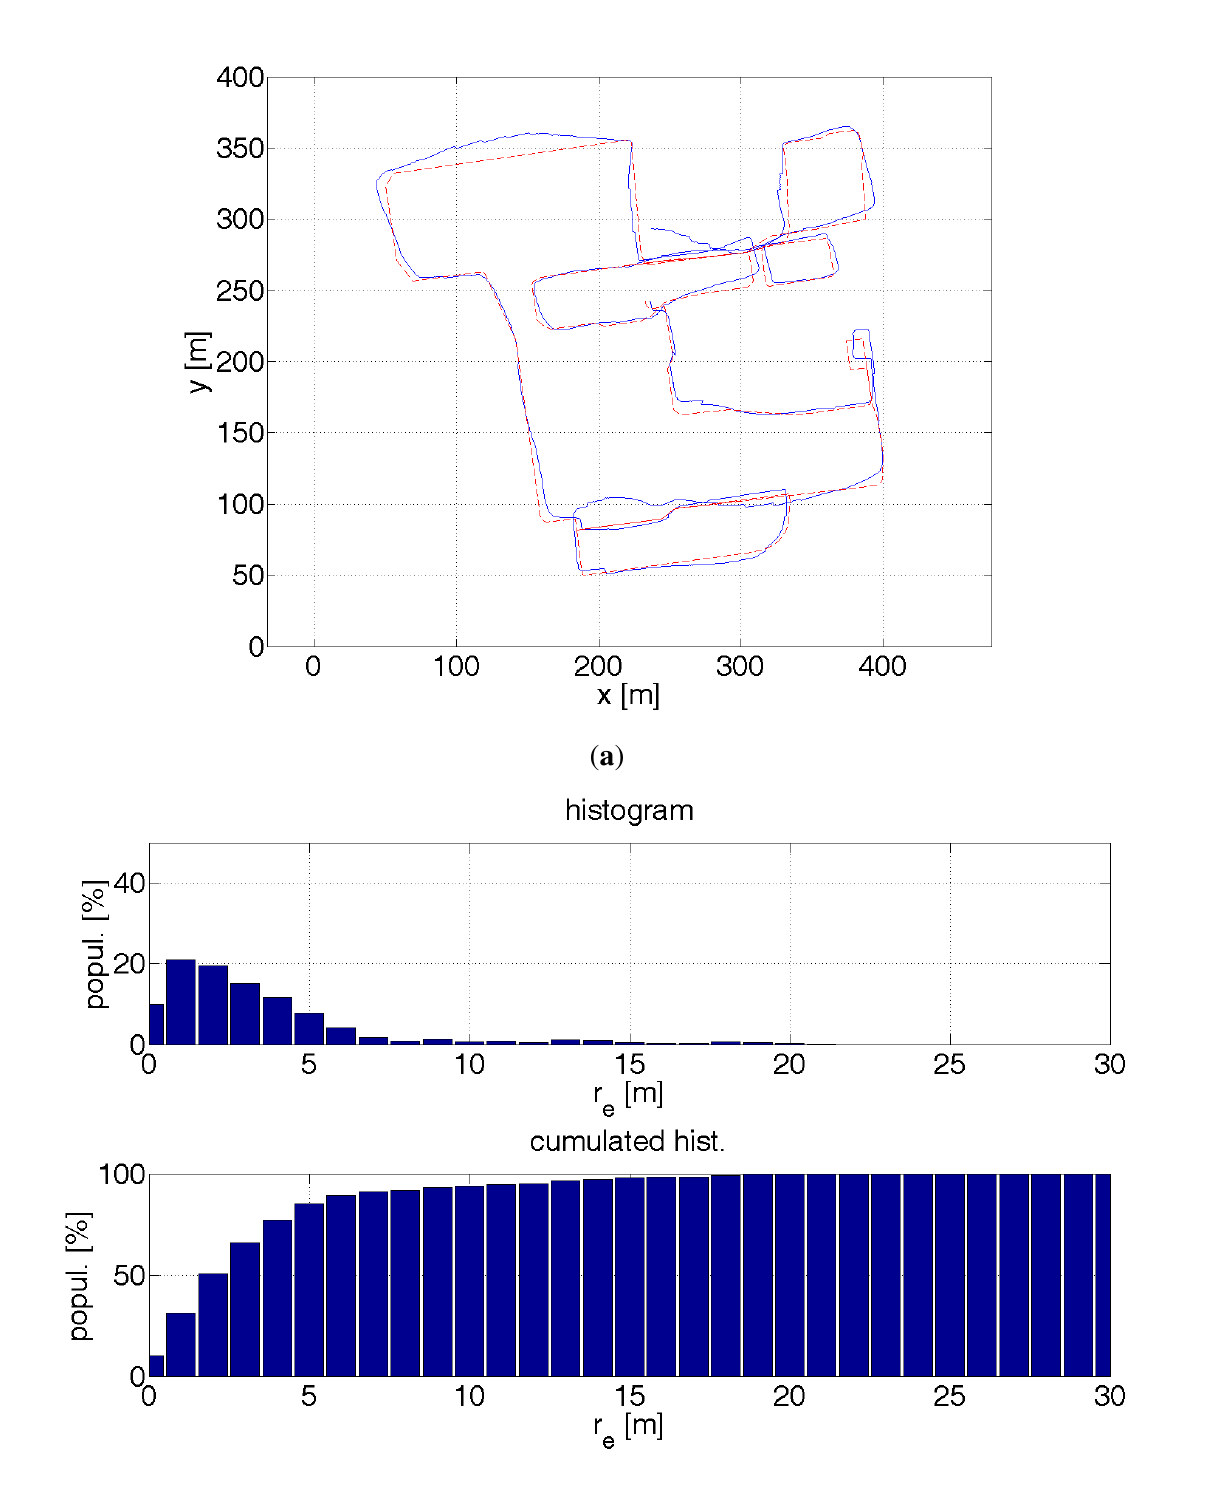
Figure 17. ( a ) Red dashed line—reference path. Blue solid line—estimated path with a help of GPS receiver and inertial sensors. The readouts from the inertial sensors enable to eliminate big errors. The accuracy improvement is not significant due to errors in estimating direction. ( b ) Histograms of distance